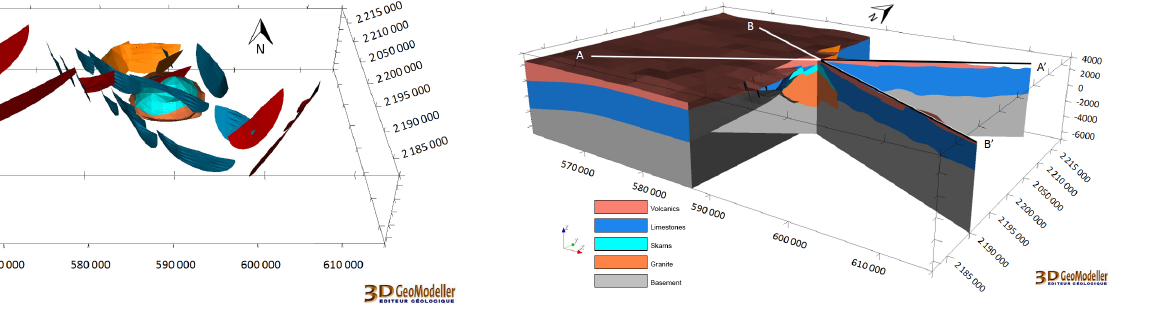
Figure 14. The Acoculco regional fault model. Twenty-six faults are modelled. Coordinate system is WGS84/UTM zone 14N.